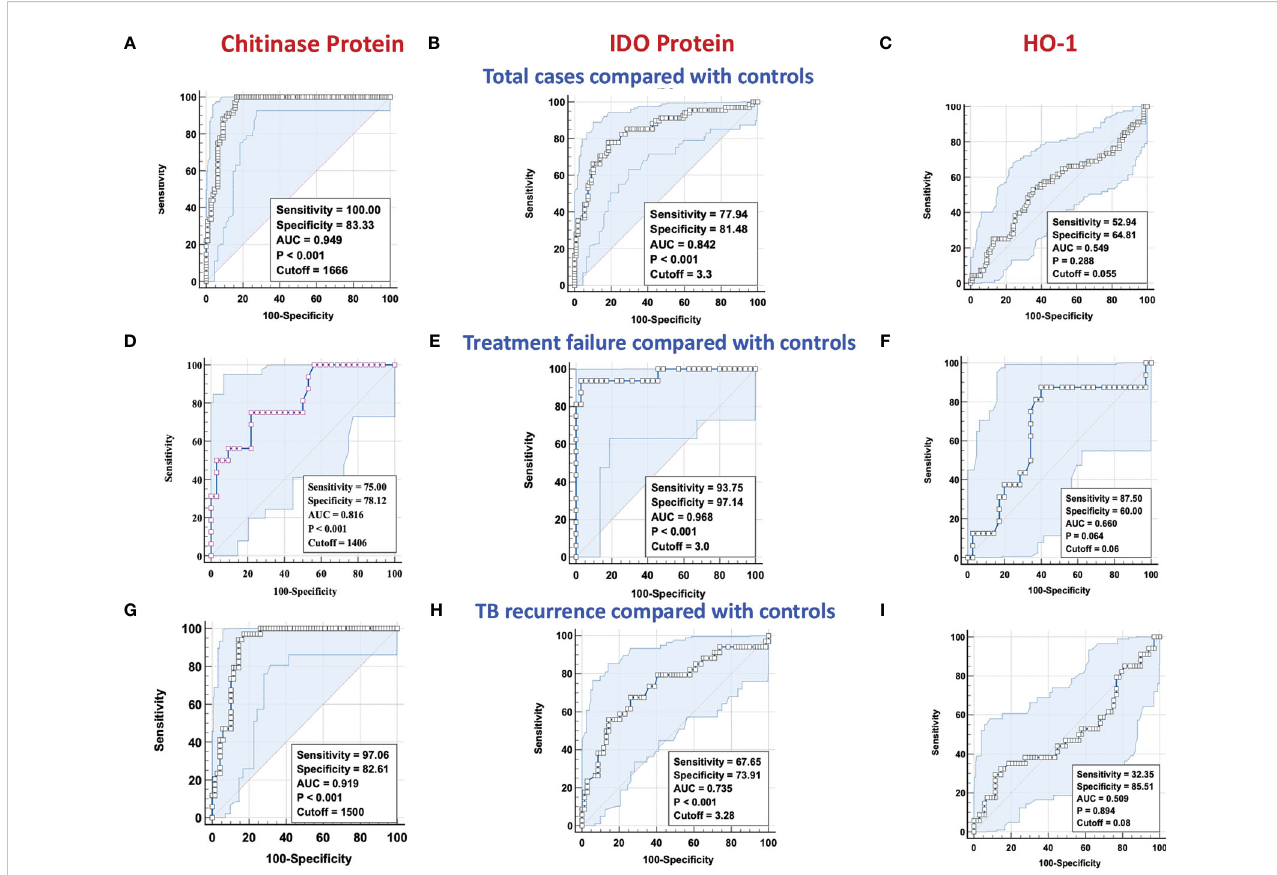
FIGURE 3 ROC analysis of chitinase protein, IDO protein and HO-1 in discriminating treatment failure and disease recurrence versus controls. Receiver operator characteristic analysis to estimate the sensitivity, speci fi city, and AUC was performed using chitinase protein, IDO protein and HO-1 to estimate the capacity of these factors to distinguish cases vs controls. (A – C) Total cases (n=68) and controls (n=108) (A) Chitinase protein (B) IDO Protein (C) HO-1. (D – F) TB Treatment failure (n=16) and controls (n=35) (D) Chitinase protein (E) IDO Protein (F) HO-1. (G – I) TB recurrence (n=34) and controls (n=69) (G) Chitinase protein (H) IDO Protein (I) HO-1. NS : No signi fi